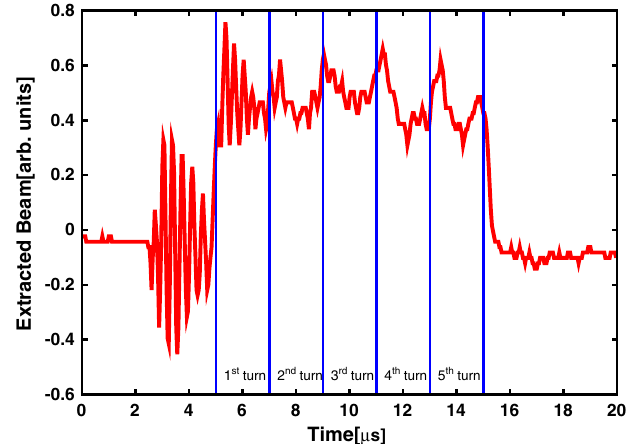
FIG. 8. Five turn spill structure measured by a current trans- former in the transfer line between the PS and the SPS. Some noise on the reading is observed before the extraction and during the first